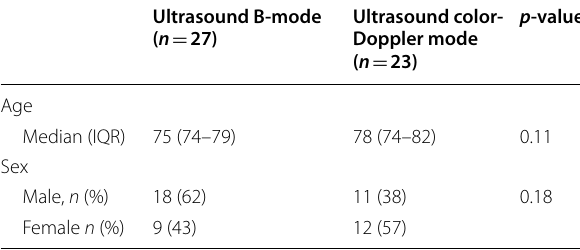
There are no demographic differences between the two subgroups